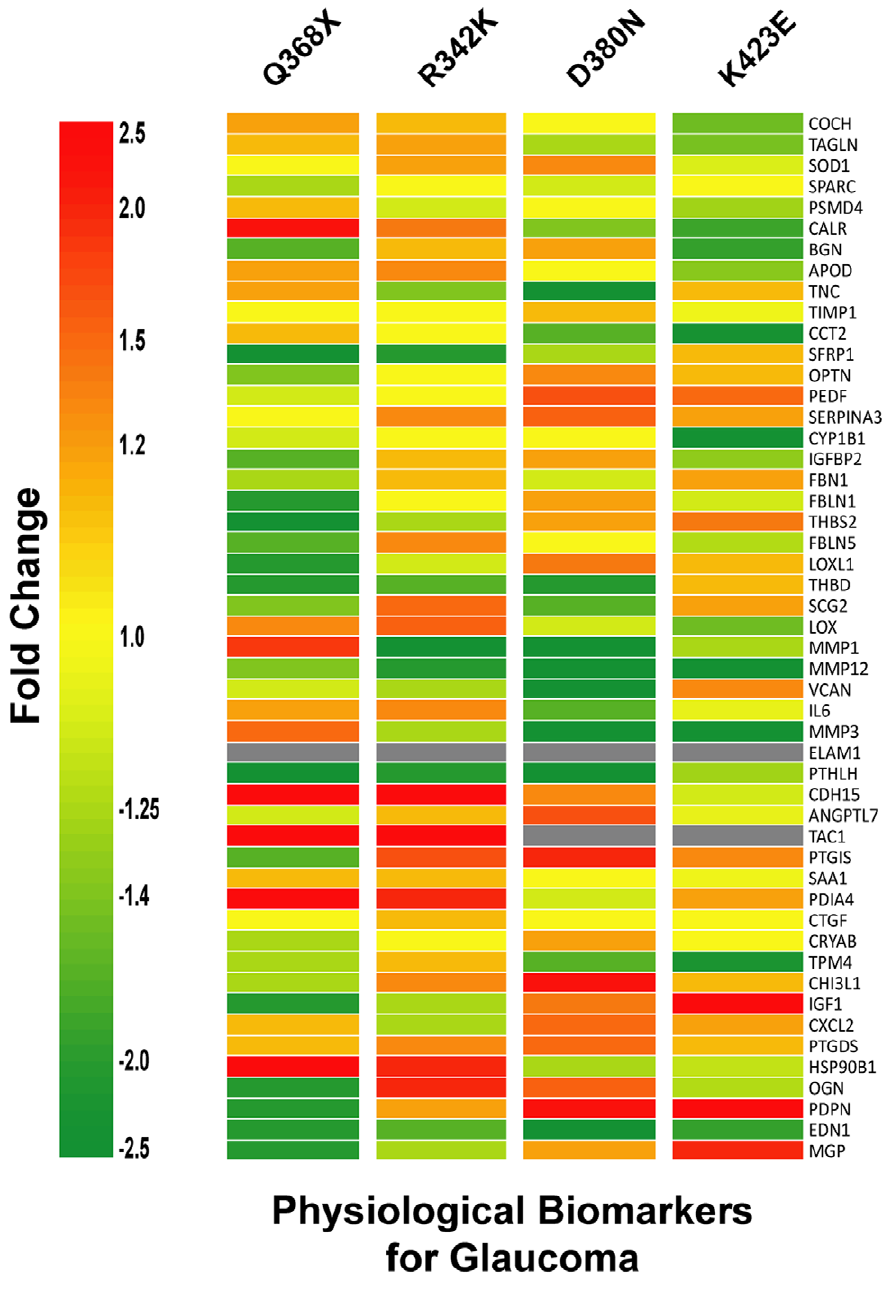
Figure 5. MYOC mutants altered most physiological biomarkers of glaucoma. Heat maps of a gene list containing 50 potential biomarkers for the human trabecular meshwork (Table S6). The biomarker gene list was generated by a comprehensive review of trabecular meshwork expression studies as indicated in the result section. Each row represents the fold change (Adeno.MYOC mutant over Adeno.Null) for a single gene in each of the four mutants. Each column represents the fold changes for all biomarkers in one MYOC mutant. The fold change for each gene is visually represented by a color, which is given by the scale bar at left. Heat maps were generated with genes lists containing the full range of fold changes. Gray cells indicate that the expression of the giving gene was below the cutoff of signal intensity value and was considered absent. doi:10.1371/journal.pone.0036301.g005 the one with highest percentage of genes and most significant subcategories which were statistically significant (P # 0.05). The (25.9%, P # 0.0001). In the Molecular Function category, the diagram of the top seven subcategories from each main group is subcategory with more genes was that of receptor binding shown in Figure 7 top. In Biological Processes, cell cycle (GO:5102) (15.8%, P # 0.0009) while the one most significant (GO:7049) contained the highest percent of genes number was the ATPase inhibitor activity (GO:42030) (P # 0.00008, 3.5% (23.1%, P # 0.0003,) and DNA replication (GO:6260) was the genes) (Figure 7 top). most significant (P # 0.000009, 13.5% genes). In Cellular Compo- nents, the extracellular region subcategory (GO:5576) was both